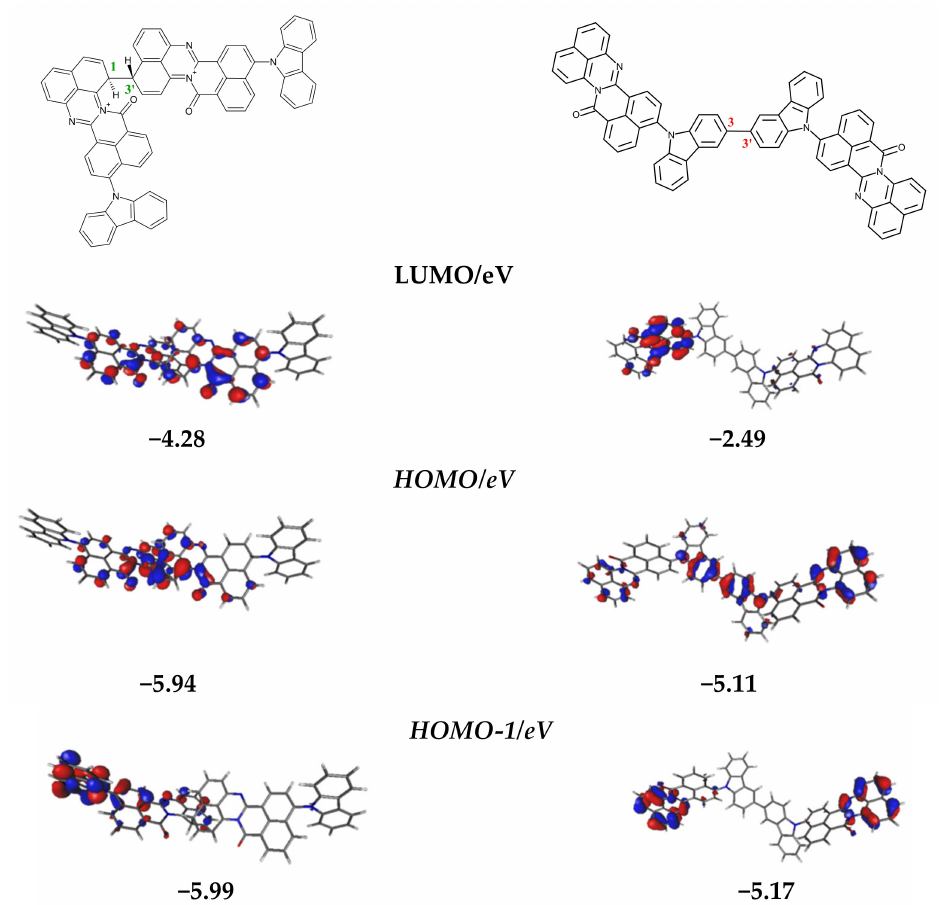
Figure 2. The shape of frontier orbitals of protonated perimidine–perimidine dimer of 1 ( left ) and neutral carbazole– carbazole dimer of 1 ( right ) calculated at B3LYP/6-31G(d)/CPCM(DCM). The isovalue is equal to 0.03 e − /au 3 in each